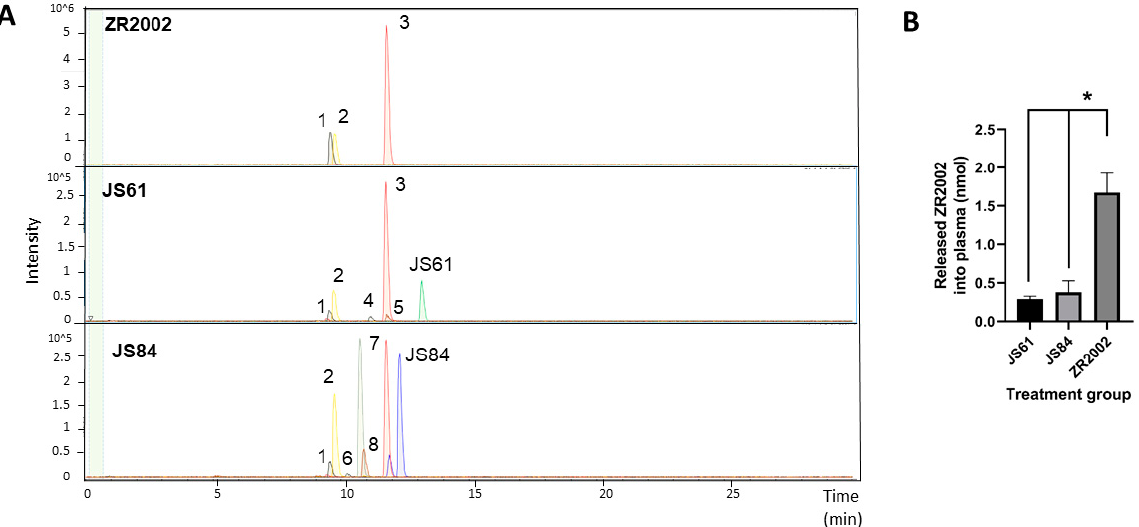
Figure A2 . Body weights of mice treated (N = 7) with the combi-molecules. ( A ) ZR2002 versus